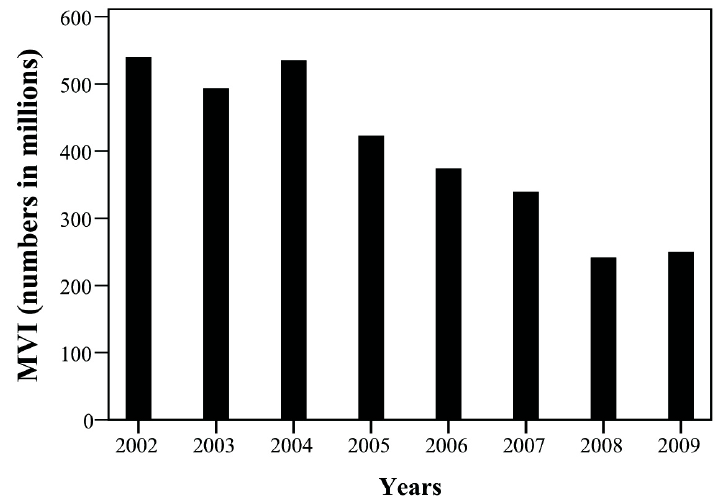
Figure 1. The temporal change of motor vehicle accidents between 2002 and 2009.